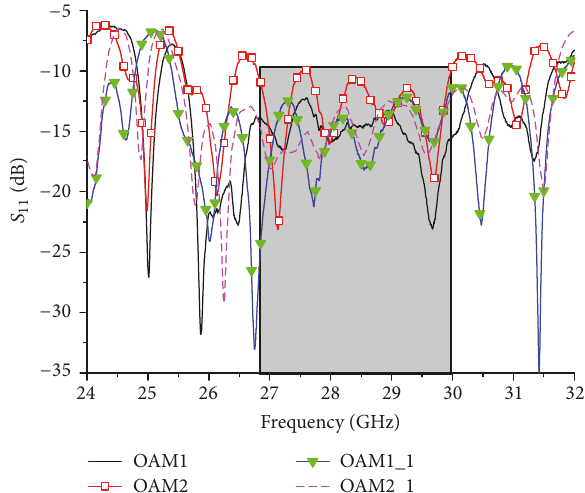
Figure 10: Measured reflection coefficients 𝑆 11 for all